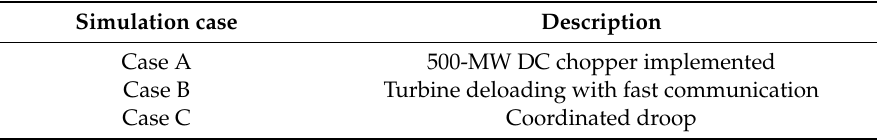
Table 3. Simulation cases.